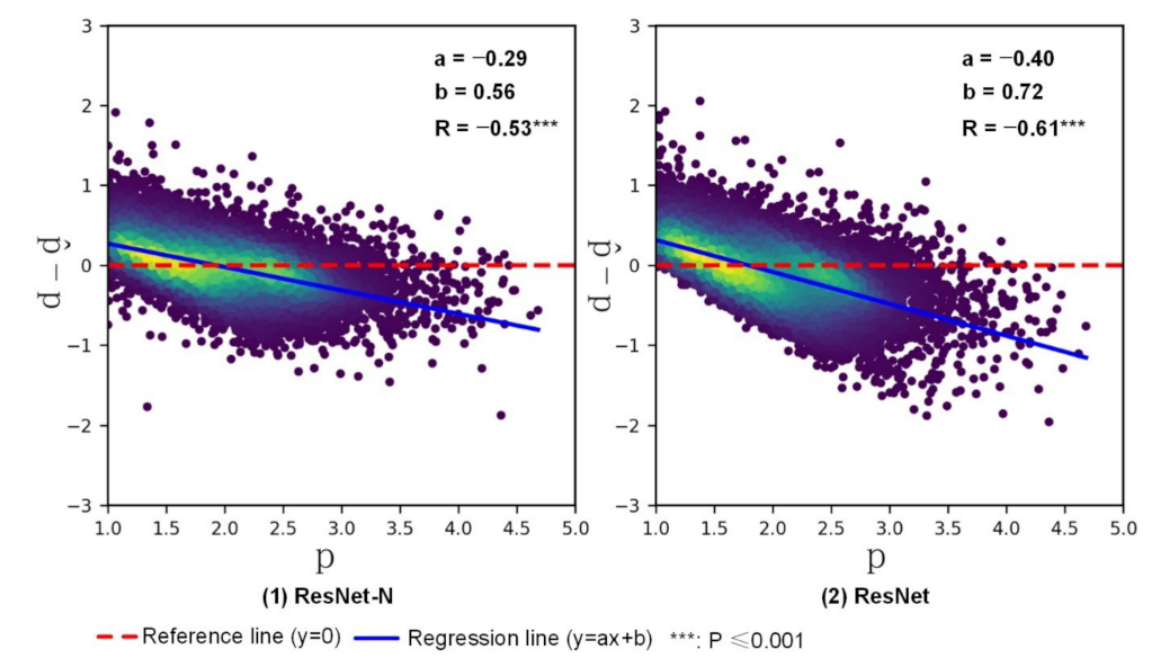
Figure 8. Scatterplots of test samples between p and ˆ p − p from ResNet-N and ResNet. ( p : true population count; ˆ p : estimated population